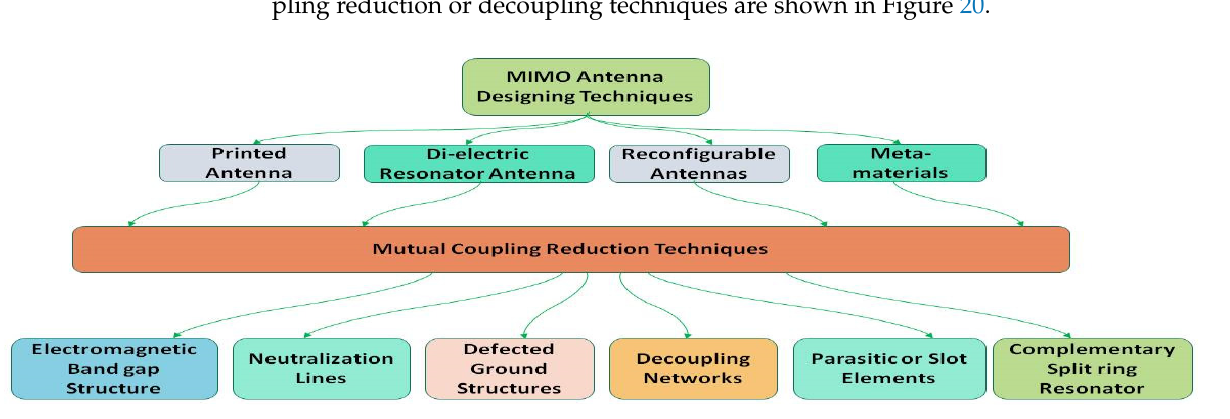
Figure 20. Designing and mutual coupling reduction technique of MIMO antennas, a summarized generic view.